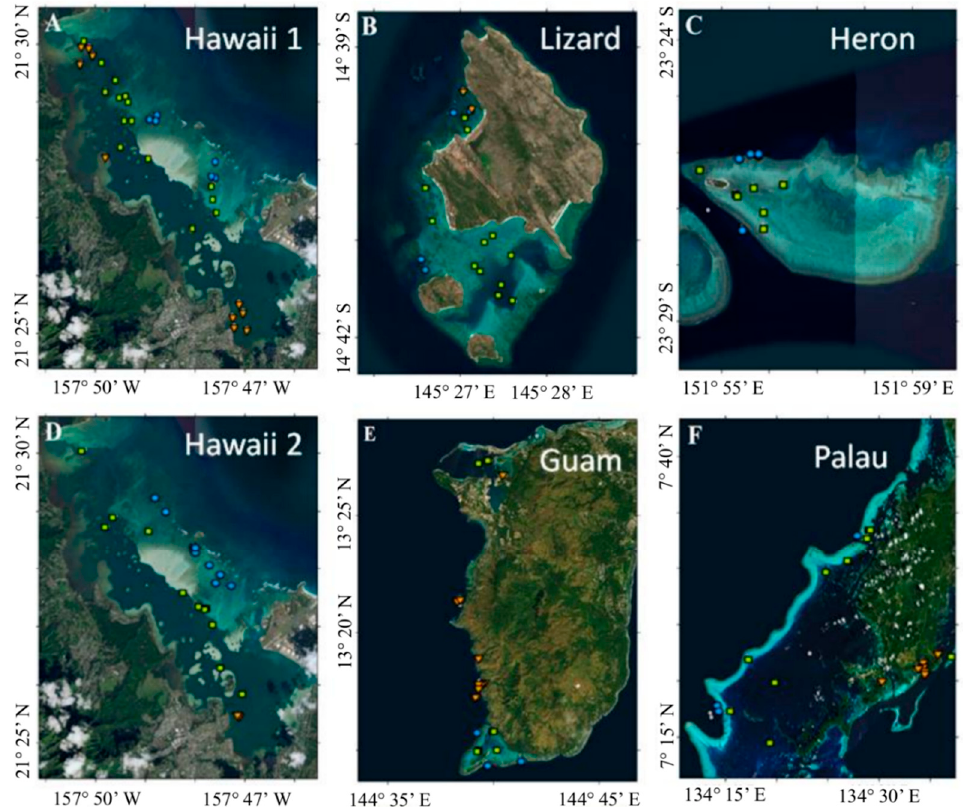
Figure 2. Optical measurement stations during Kaneohe Bay during 2016 ( A ), Lizard Island ( B ), Heron Island ( C ), Kaneohe Bay during 2017 ( D ), Guam ( E ), and Palau ( F ) campaigns. Markers correspond to one sample ( ● ), 2–4 samples ( " ), or 5–7 samples ( # ). Colors correspond to geomorphic reef zones (see